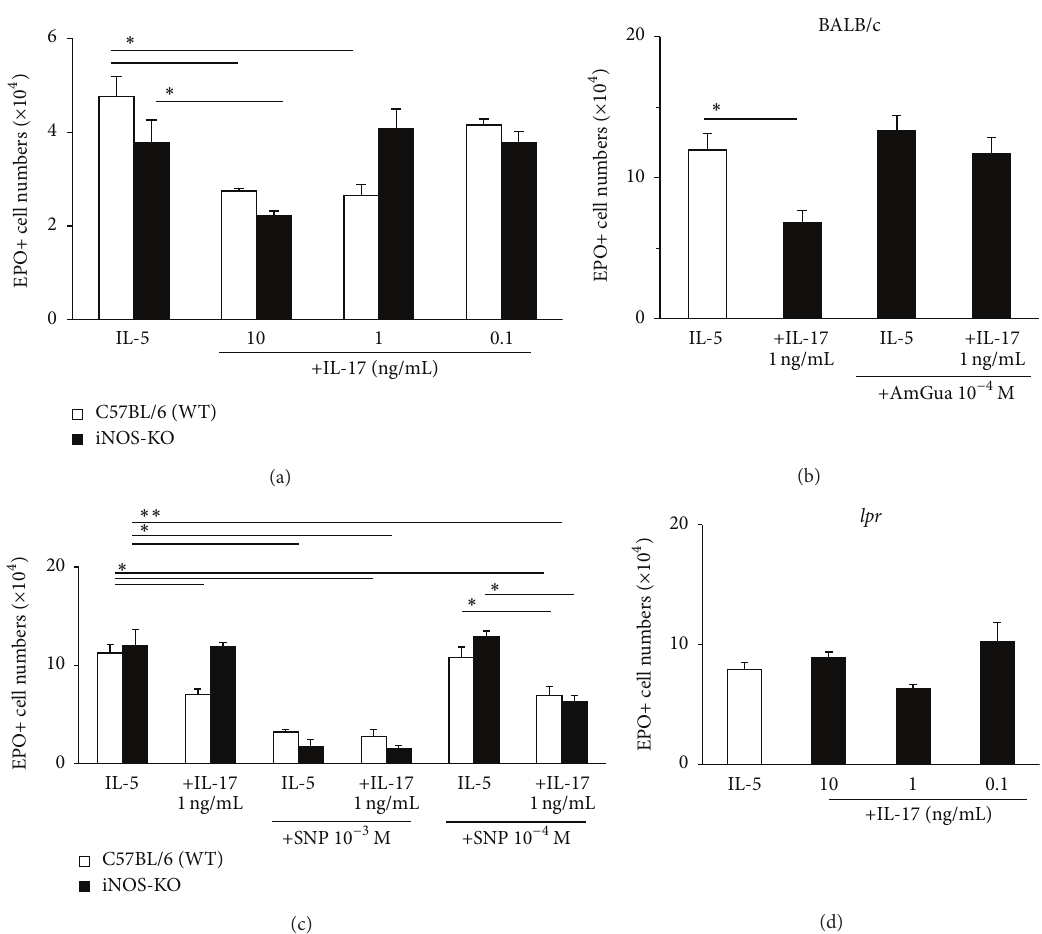
Figure 2: Dependence of IL-17A on iNOS and synergism between IL-17A and exogenous NO in iNOS-deficient bone-marrow. Bone-marrow cultures were established with IL-5, alone or in association with IL-17A, from wild-type (WT) control (C57BL/6, white bars) and iNOS- deficient (iNOS-KO, black bars) mutant C57BL/6 mice (a, c) or from BALB/c wild-type mice (b) or from CD95-deficient lpr mutant BALB/c (d), as described in legend of Figure 1. Data (mean ± SEM), 𝑛 = 3 (a, c, and d), 𝑛 = 4 (b), are the numbers of EPO+ cells recovered at day 7. (a) Concentration-response relationship for IL-17A on WT and iNOS-deficient bone-marrow. (b) Blockade of IL-17A effect by iNOS- selective inhibitor aminoguanidine (AmGua). (c) Concentration-response relationships for IL-17A and SNP, separately and in combination, in wild-type and iNOS-deficient bone-marrow, showing synergism between IL-17A (1ng/mL) and NO donor SNP (10 −4 M) in iNOS-deficient bone-marrow. (d) Dependence of IL-17A effectiveness on CD95 (comparing with (b), white bar and first black bar). ∗ 𝑃 < 0.05 and ∗∗ 𝑃 < 0.01 for the differences between the indicated points or in (b), relative to the respective IL-5 (negative)